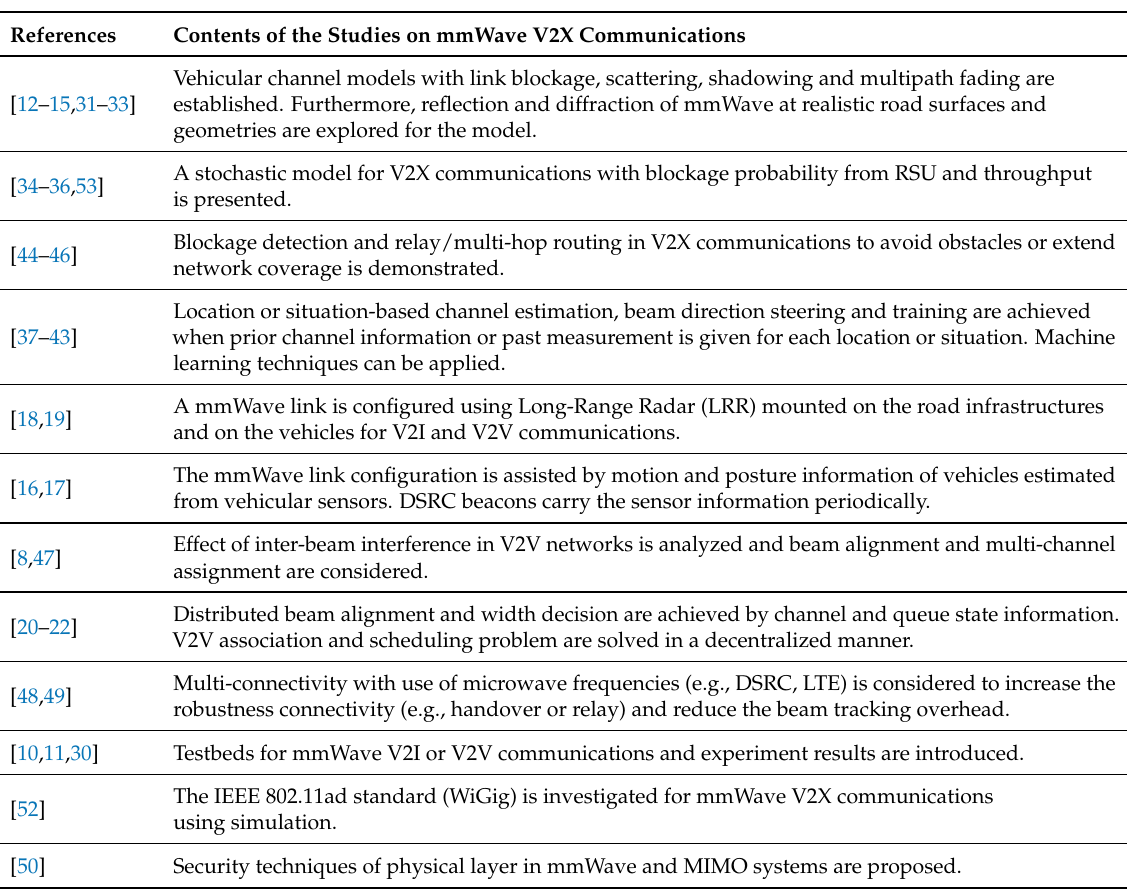
Table 1. Survey on mmWave-based V2X